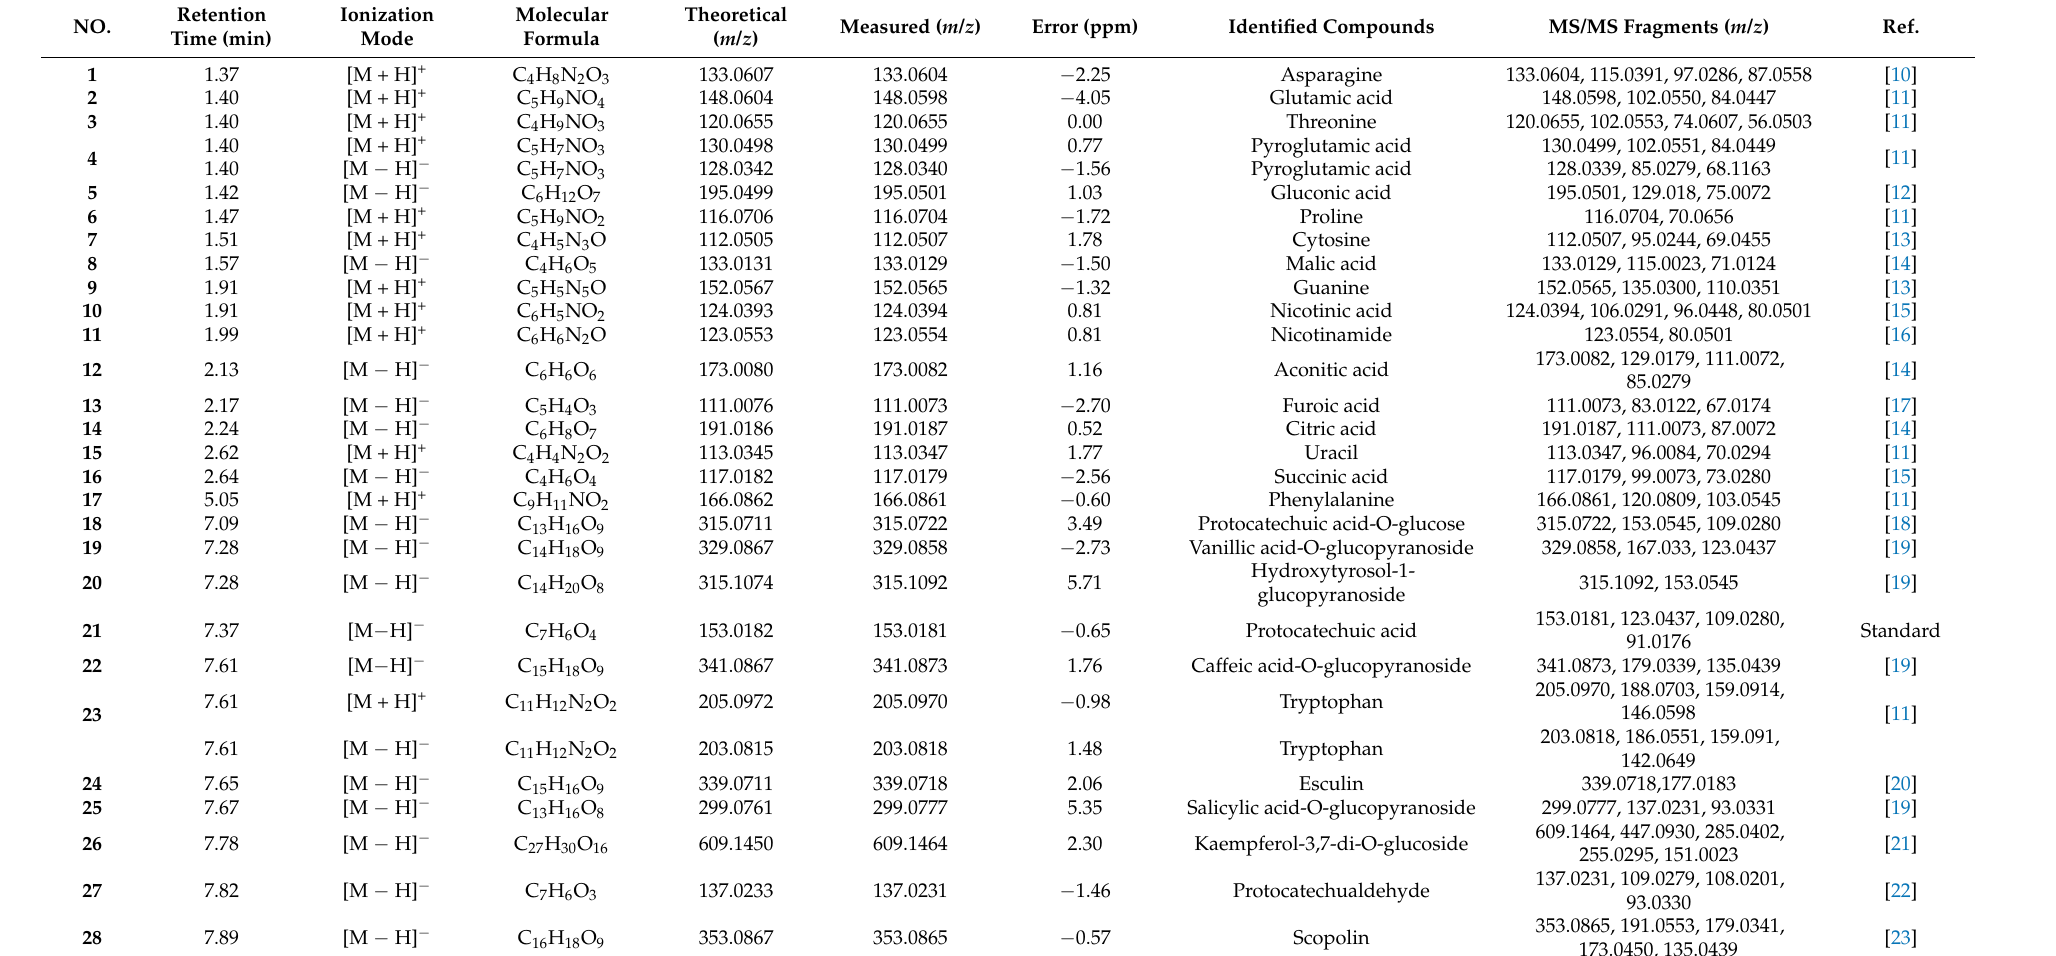
Table 1. 69 compounds identified in the 80% methanol extract of RS and their UHPLC-Q-Orbitrap HRMS